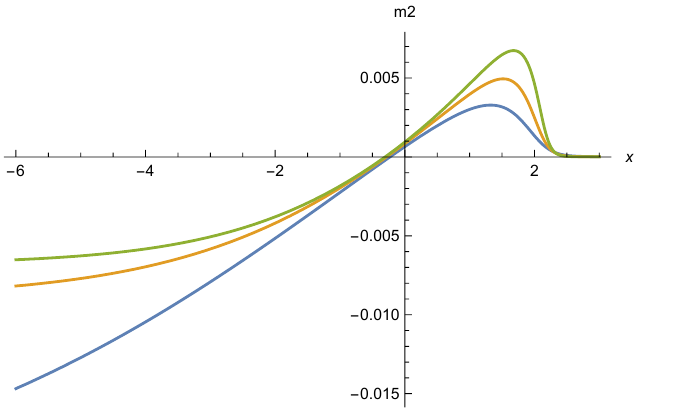
Figure 8. Mass term ˜ m 2 ( x ) as function of x = ln ( ˜ ρ ) for w 0 = 0.06 (upper green curve), w 0 = 0.05 (middle orange curve), and w 0 = 0.042 (lower blue curve). Parameters are the same as for Figure 6.